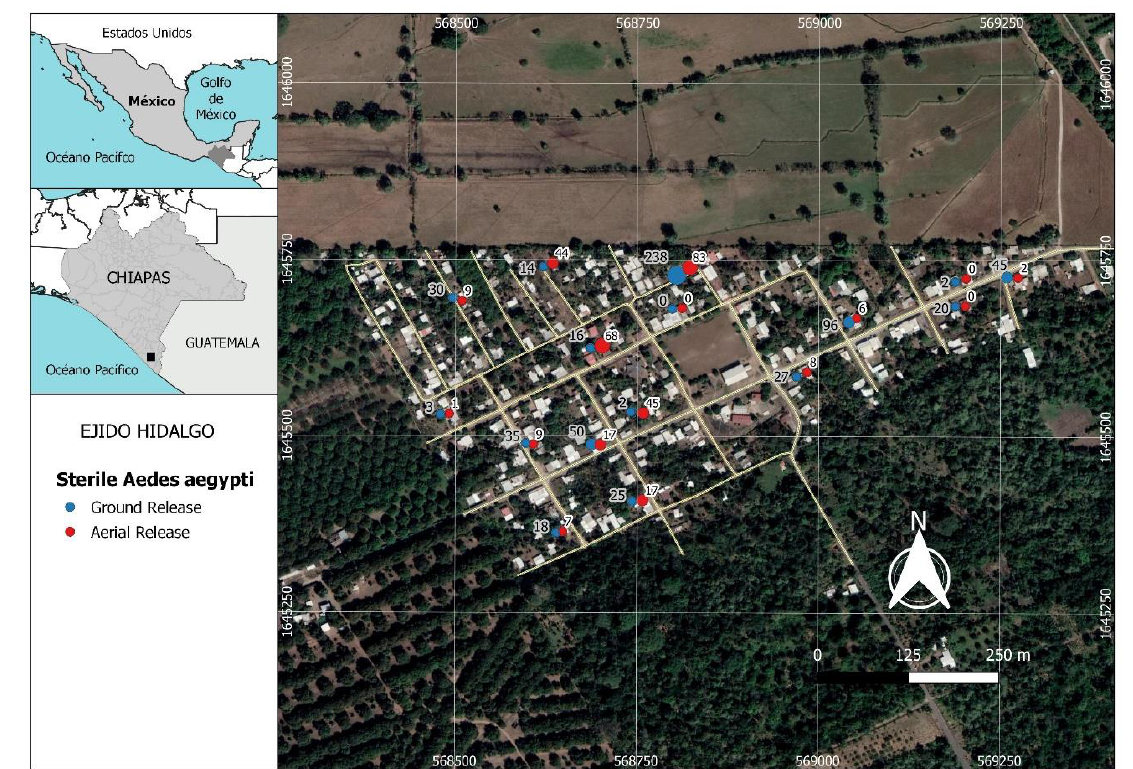
Figure 1. Distribution of sampling points used to recapture sterile males of Aedes aegypti released in Hidalgo village in Chiapas, southern Mexico. Each pair of points (red and blue) represents the results from one trap in one house. The blue points and numbers on the left side correspond to the recaptures of males released at ground level. The red points and the numbers to the right side represent recaptures of males released by aerial drone. Values represent the total number of sterile males recaptured in each trap during the 8 weeks of releases using both ground and aerial methods.